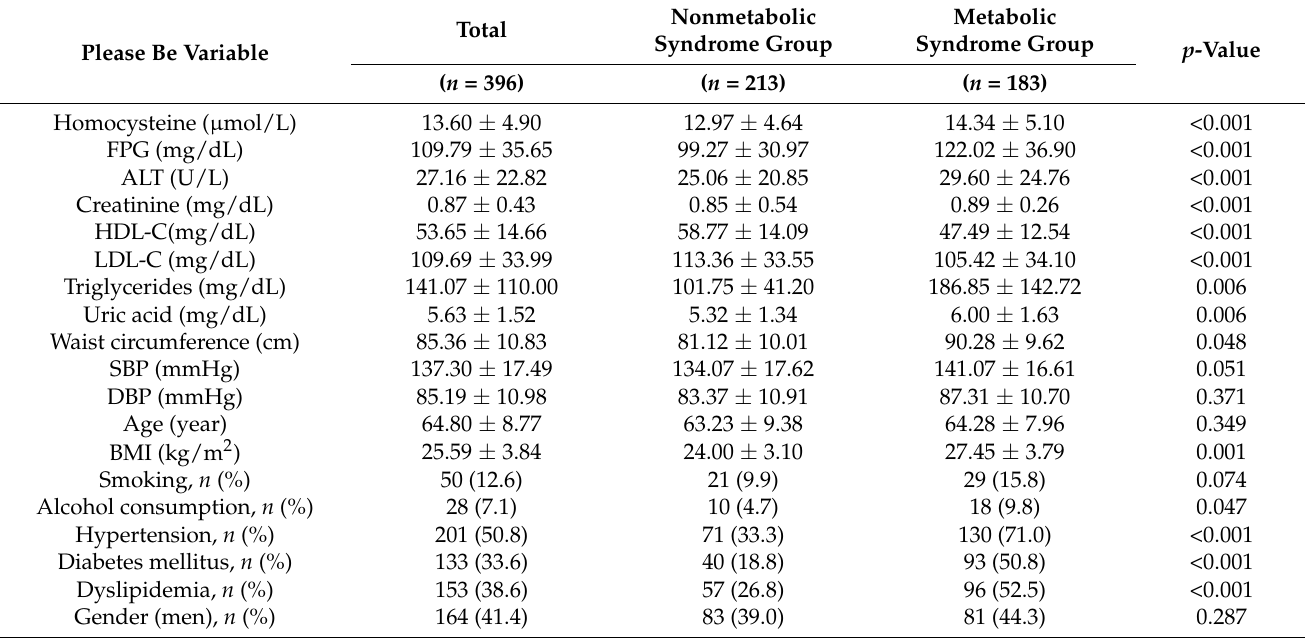
Table 1. The characteristics of study subjects by metabolic syndrome